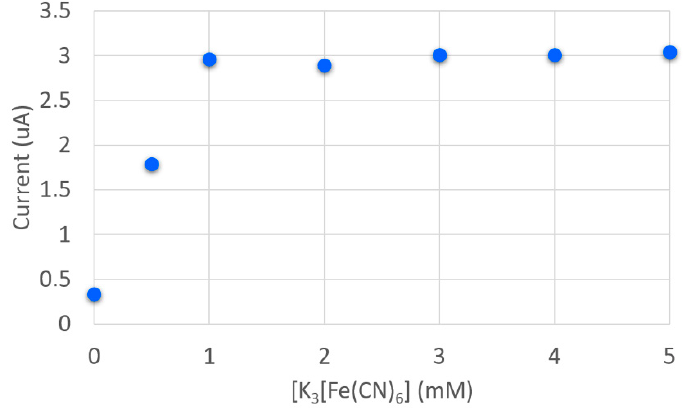
Figure 2. Calibration of different concentration of K 3 [Fe(CN) 6 ] in 0.24 U/mL ALDH, 0.24 U/mL DP, 1 mM NAD + , 2 mM PPA and 0.1% BSA in 0.1 M phosphate + 0.1 M KCl buffer solution pH 8.0.